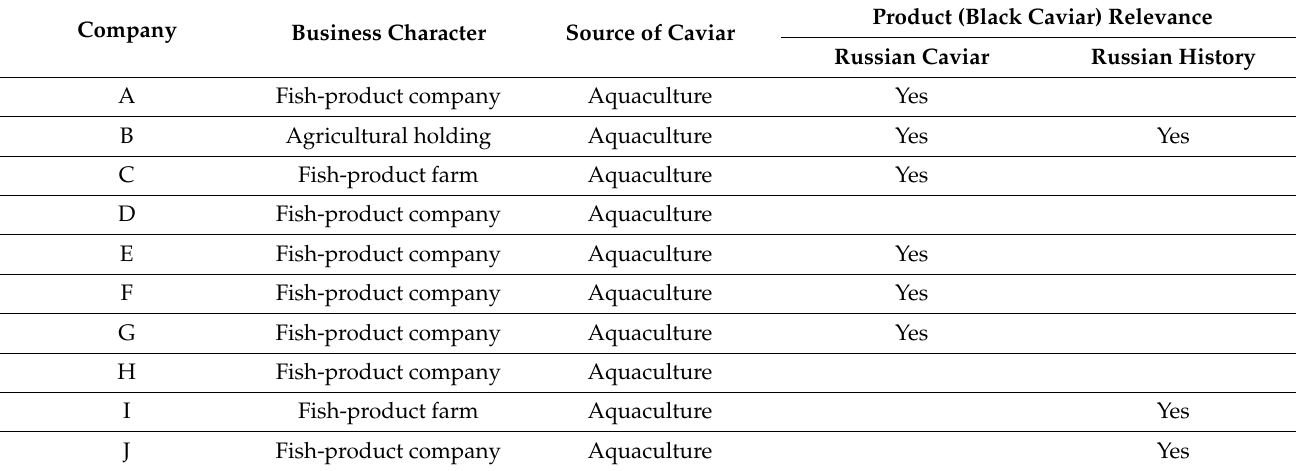
Table 1. Basic information about the Russian full-cycle black caviar producers considered in this study.